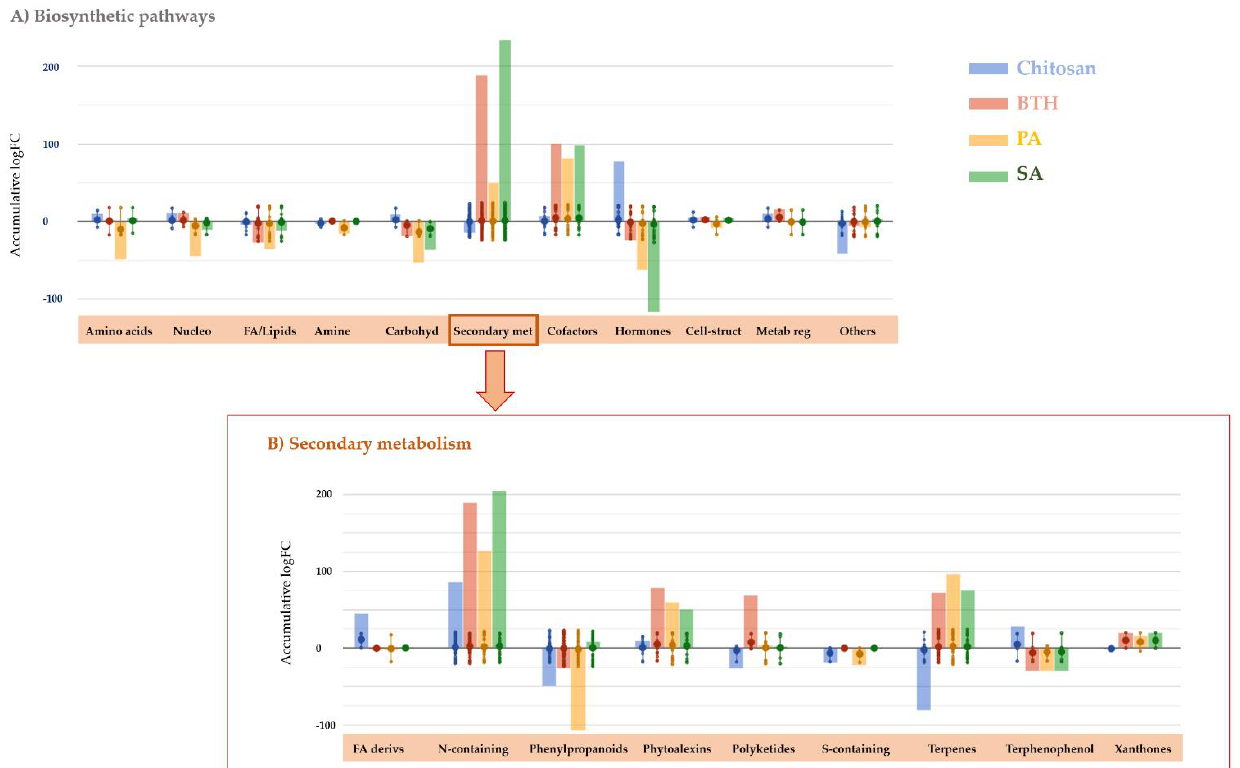
Figure 3. Metabolic processes ( A ) and secondary metabolite biosynthesis ( B ) modulated in tomato leaves following the treatments with elicitors. The metabolomics dataset produced through UHPLC- ESI/QTOF-MS was subjected to ANOVA and FC analysis ( p < 0.01, FC ≥ 7), and differential metabo- lites were loaded into the PlantCyc Pathway Tool (https://www.plantcyc.org/ Plant Metabolic Network; accessed on 20 November 2021). The x axis represents each set of metabolic subcategories, while the y axis corresponds to the accumulative log fold change (FC). The large dots represent the average (mean) of all FCs for the different metabolites in the class, while the small dots represent the individual log FC. The abbreviated subcategory names on the x axis correspond to: Nucleo: nucleosides and nucleotides; FA/lipids: fatty acids and lipids; Amines: amines and polyamines; Car- bohyd: carbohydrates; Secondary met: secondary metabolism; Cofactors: cofactors, prosthetic groups, electron carriers, and vitamins; Cell-struct: plant cell structures; Metab reg: metabolic regulators; FA derivs: fatty acid derivatives; N-containing: nitrogen-containing secondary metabolism; S-containing: sulfur-containing secondary metabolism; Terpenophenol: terphenophenolic compounds.